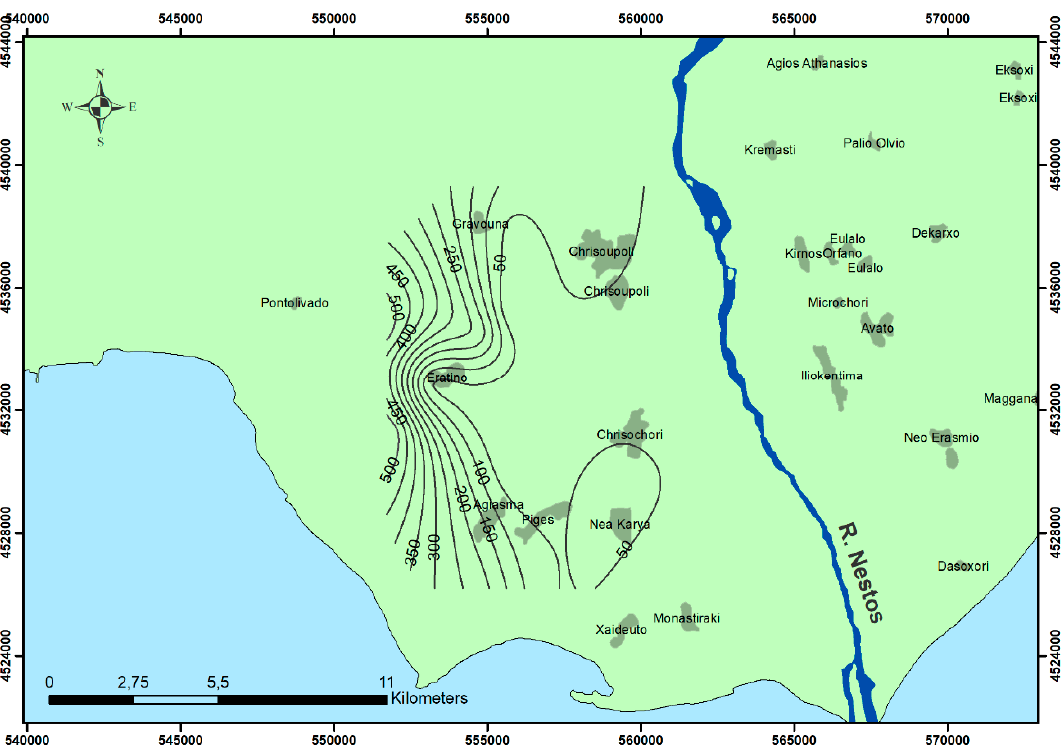
Hydrology 2022 , 9 , x FOR PEER REVIEW Figure 12. Electrical conductivity distribution map ( μ S/cm) of the confined aquifer (October 2019). Figure 12. Electrical conductivity distribution map ( µ S/cm) of the confined aquifer (October 2019).